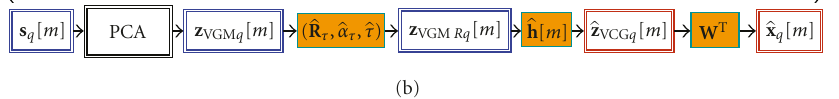
Figure 5: Detailed representation of our procedure: (a) training step, (b) reconstruction step.